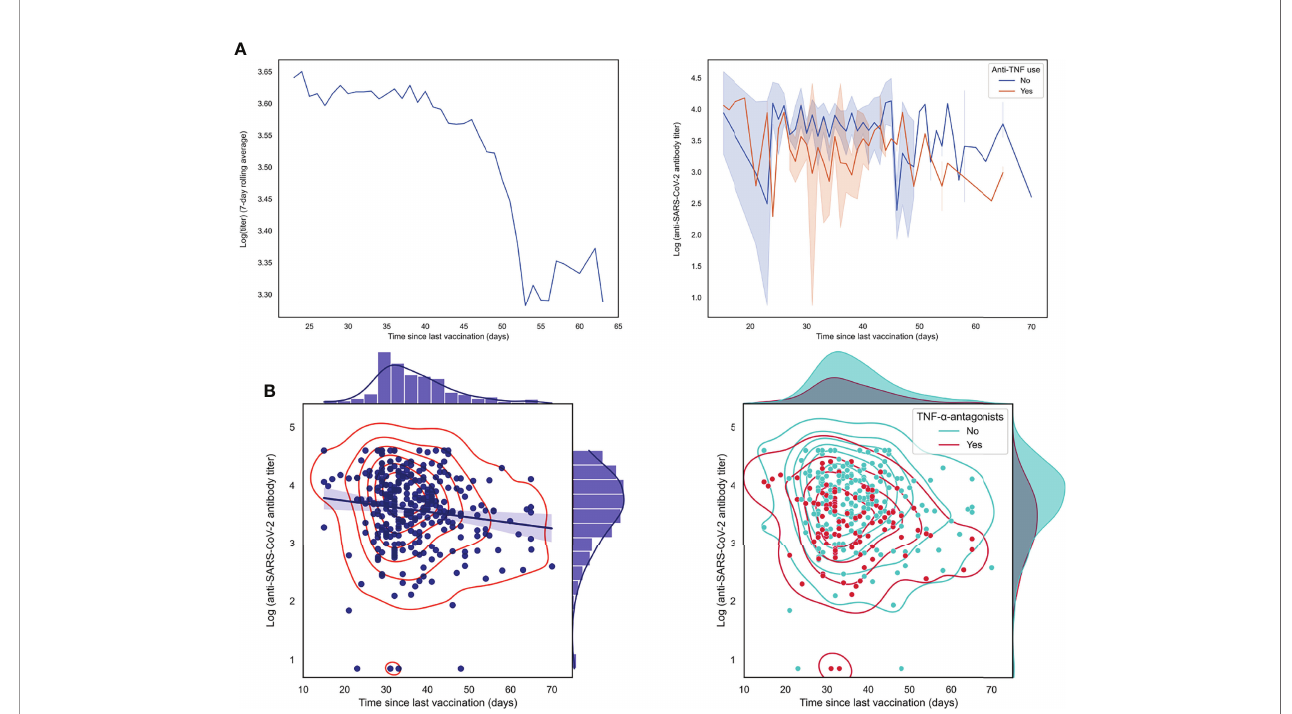
FIGURE 5 | Log-transformed anti-SARS-CoV-2 antibody titers are negatively associated with the elapsed time since the last vaccination was received. (A) Patients with IBD who received their last vaccination less recently show lower antibody titers, as demonstrated by a 7-day rolling average and by individually connected data points strati fi ed by use of TNF- a -antagonists. (B) Scatter plots with associated kernel density estimations showing an inverse association between anti-SARS-CoV-2 antibody titers (log-transformed) and time since last vaccination was received (left lower panel), an association which was not signi fi cantly modi fi ed by the use of TNF- a -antagonists (lower right